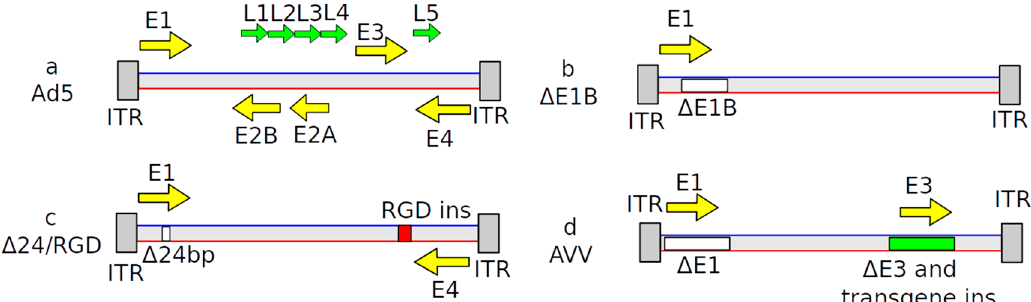
Figure 2. Schematic of the genome structures of adenovirus type 5 (Ad5) and Ad5-based vectors. ( a ) Wild-type Ad5 virus. Arrows indicate transcriptional units. ITR—Inverted terminal repeat. ( b ) In the ONYX-015 adenoviral vector, the E1B gene is deleted. ( c ) DNX-2401 adenoviral vector structure. Δ 24 bp indicates 24 base pairs’ deletion in the Rb-binding domain of the E1A gene; RGD ins indicates an insertion of an additional peptide sequence in the Ad fiber-encoding part of the genome. ( d ) Adenoviral vectors, often referred as AVVs in the literature, are replication-incompetent viral particles produced by deleting E1 and E3 genes and inserting a desired transgene. Such vectors are widely used in experimental neuroscience for gene delivery by various groups, including ourselves [23–25].